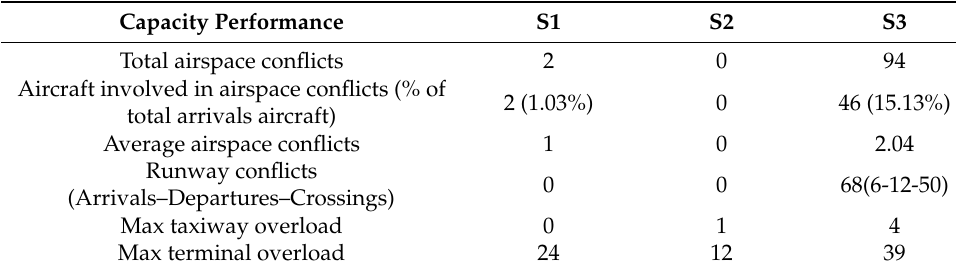
Table 7. Capacity performance for Scenarios S1, S2 and S3.